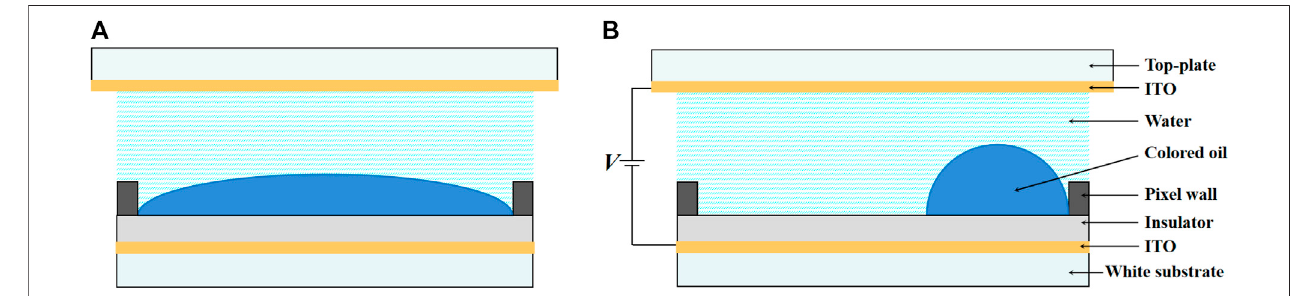
FIGURE 1 | Driving principle and pixel structure of EWDs. The optical stack consists of the glass substrate, indium tin oxide (ITO), a hydrophobic insulator layer, pixelwall,coloredoil,andwater. (A) Withoutappliedvoltage,ahomogeneousoil fi lmispresentandthepixelisincoloredoff-state. (B) Withanappliedvoltage,theoil fi lm is shrunk to a corner and the pixel is in white on-state.